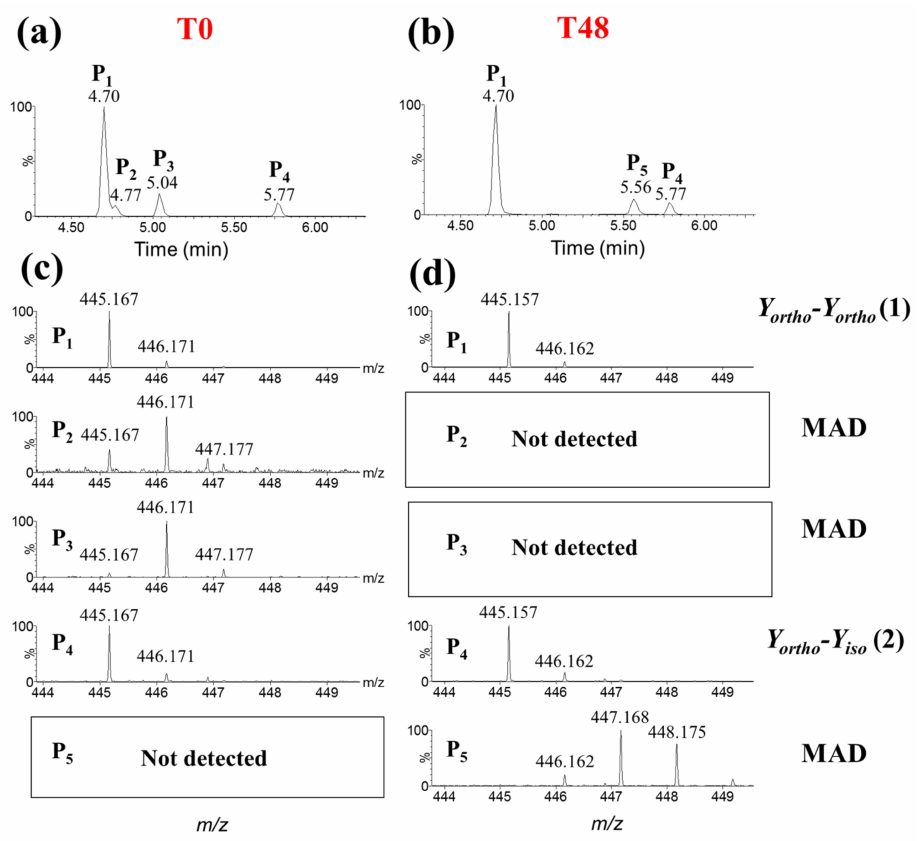
Figure 1. Oxidation of N-acetyl-L-tyrosine (Ac-Y) at 40 Gy in N 3 • production conditions. Extracted ion chromatograms m / z 445.16 ± 0.05 ([M + H] + ) after oxidation in H 2 O at ( a ) T0 (0 h); ( b ) T48 (48 h). Full scan MS spectra extracted at RT of dimers after oxidation in D 2 O at ( c ) T0 (0 h) and ( d ) T48 (48 h). Minor peaks in mass spectra arise from isotopic